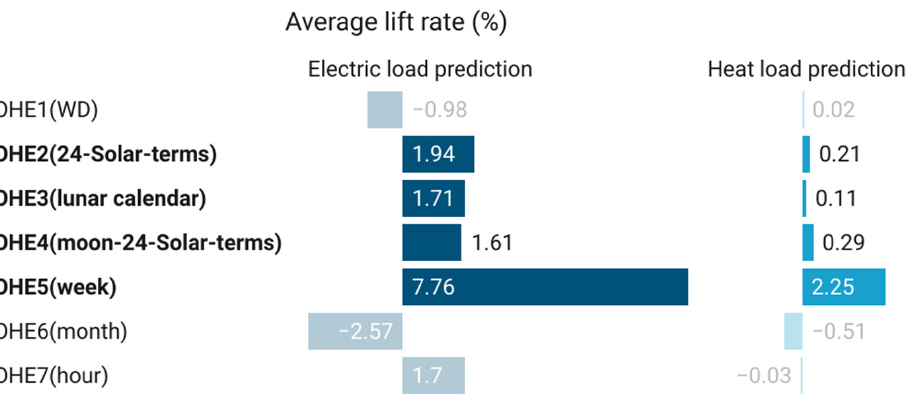
Figure 11. Average increase in the R 2 of the model (logic features).